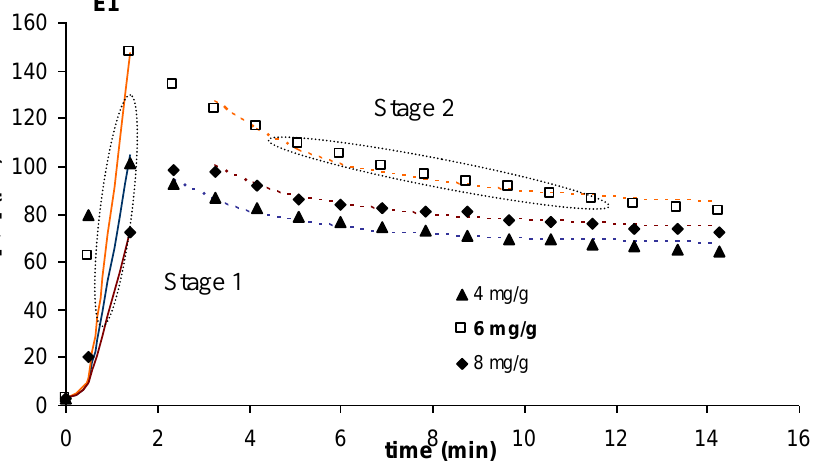
Figure 5. Fitting of Equations 2 and 3 to the kinetic curves obtained with E1.